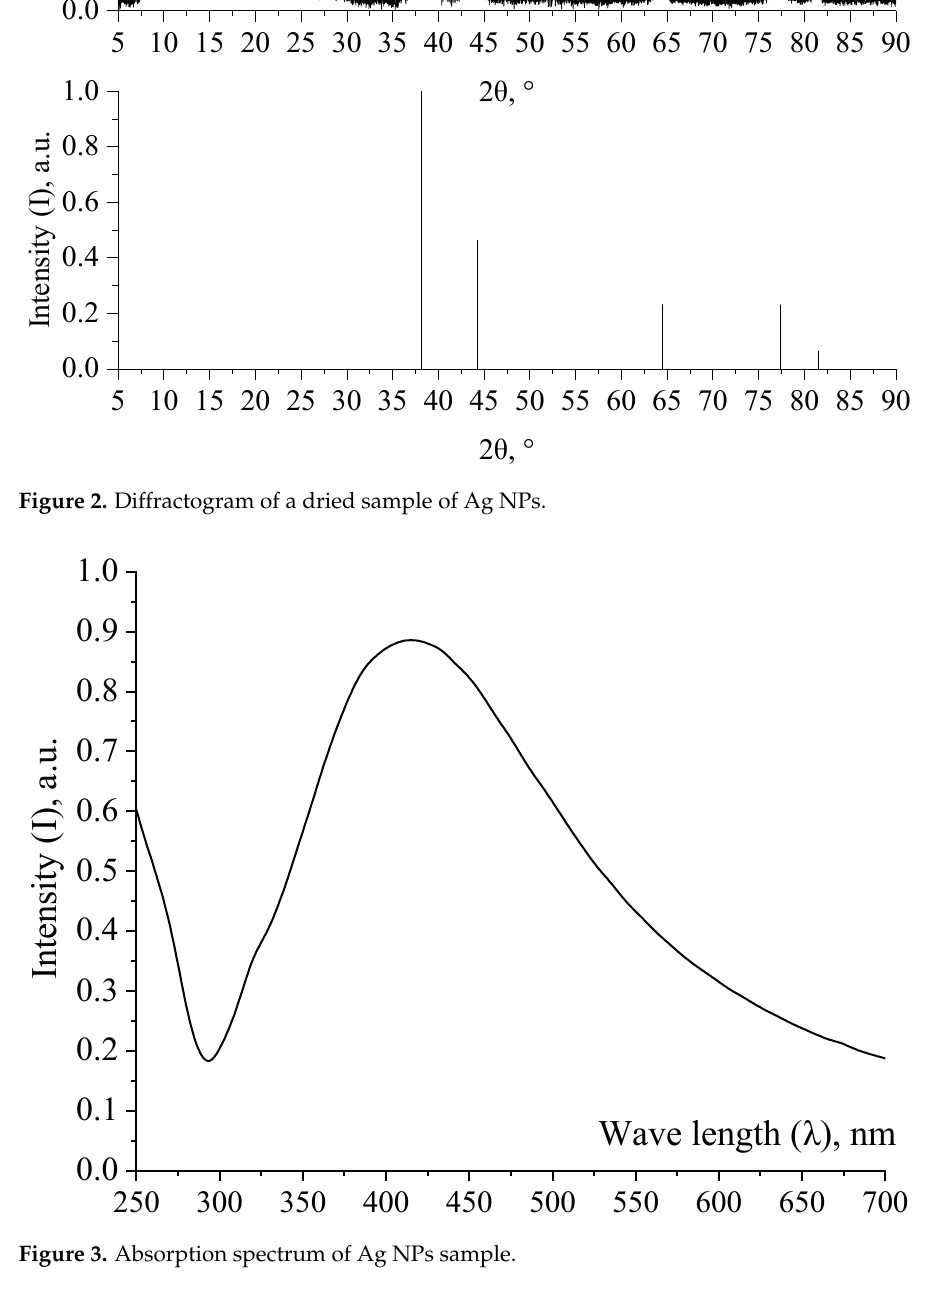
Figure 3. Absorption spectrum of Ag NPs sample.